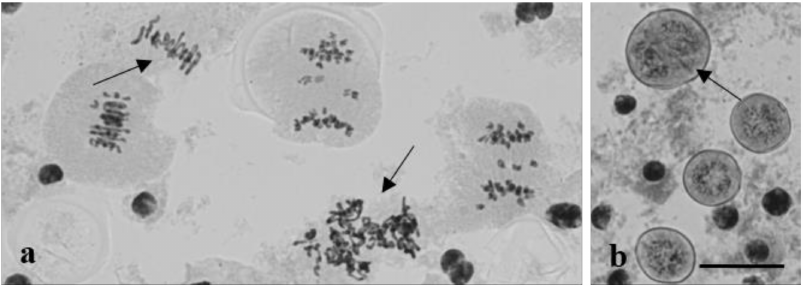
Figure 15. Rye chromosomes 1R1R and 4R4R form rod bivalents at metaphase I. Scale bar = 40 µ m. Chromatin migration was also detected in meiosis. Cytomixis was identified in MI meiocytes and in pollen grains (Figure 16). Chromosome disjunction was not disturbed in donor cells (with fewer chromosomes). In contrast, the division machinery was inoperative in the recipient cells, and chromosomes occurred in indistinct clusters.